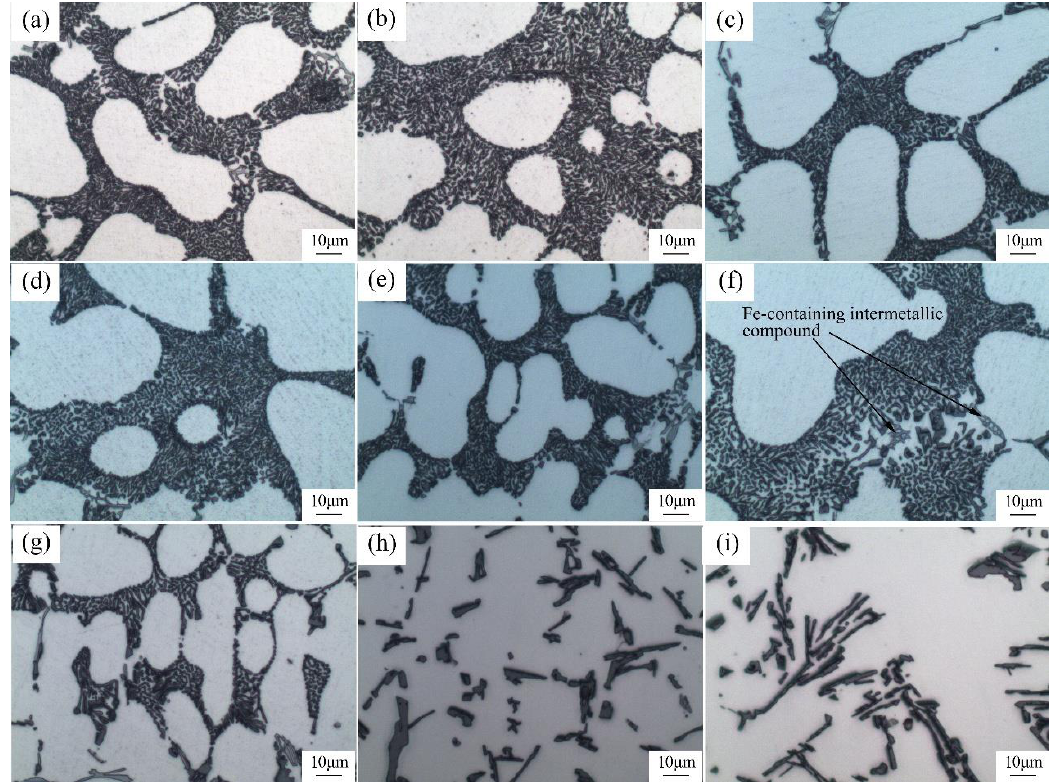
Figure 4. Morphology of the eutectic Si cast from the melt with 0.06 wt.%Sr addition holding for different times at 750 °C: ( a ) 10 min, ( b ) 20 min, ( c ) 30 min ( d ), 60 min, ( e ) 90 min, ( f ) 120 min, ( g ) 150 min, ( h ) 180 min, and ( i ) 240 min.